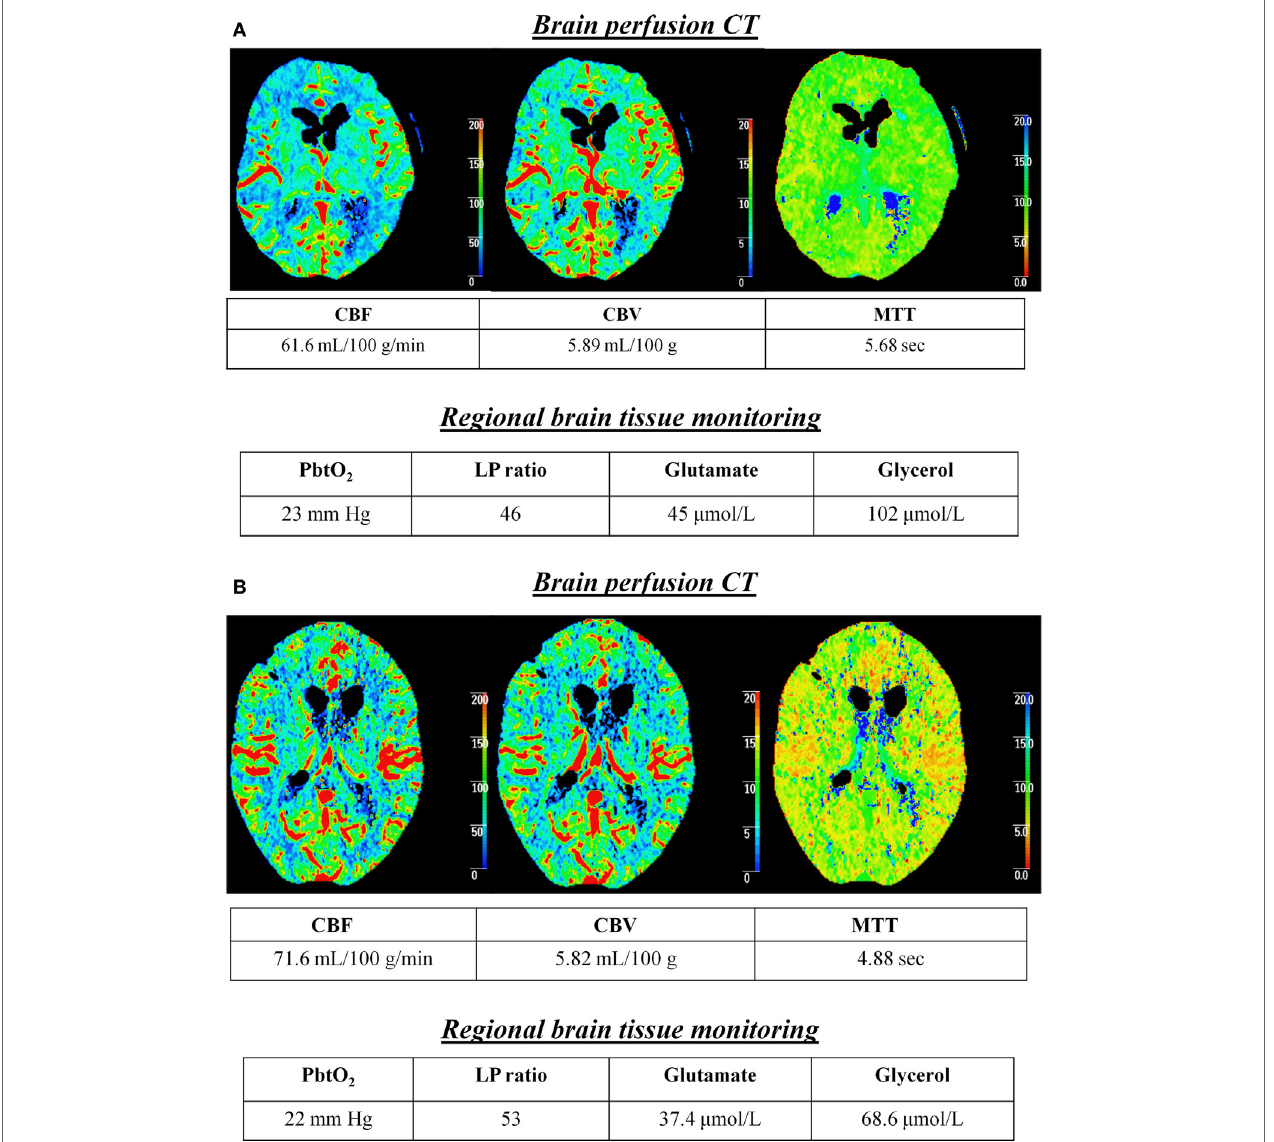
FigUre 1 | Cerebral energy dysfunction is associated with normal or hyperemic CBF in the early brain injury phase of aneurysmal subarachnoid hemorrhage. Illustrative examples of two patients in whom cerebral energy dysfunction was associated with brain perfusion CT (PCT) showing normal (a) or hyperemic (B) CBF. Time from PCT to subarachnoid hemorrhage was 16 h in patient (a) and 38 h in patient (B) . Brain extracellular concentrations of lactate/pyruvate (LP) ratio, glutamate, and glycerol were measured with a 20 kDa cerebral microdialysis catheter that was located in the subcortical white matter, adjacent to a brain tissue PO 2